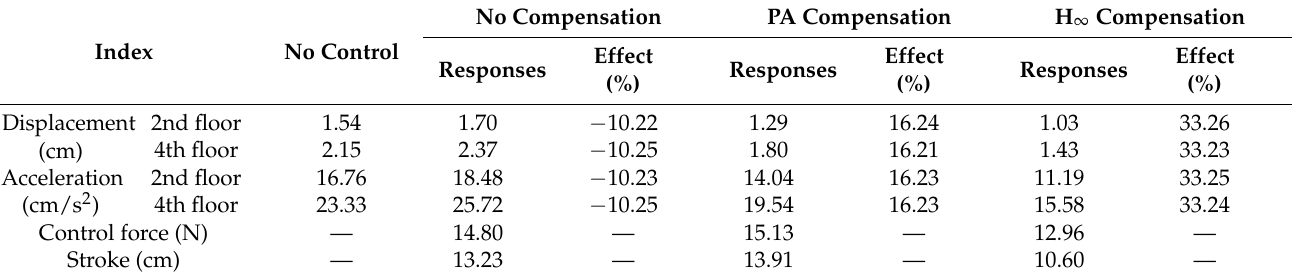
Table 3. The control effects under the numerical results (mean square values).